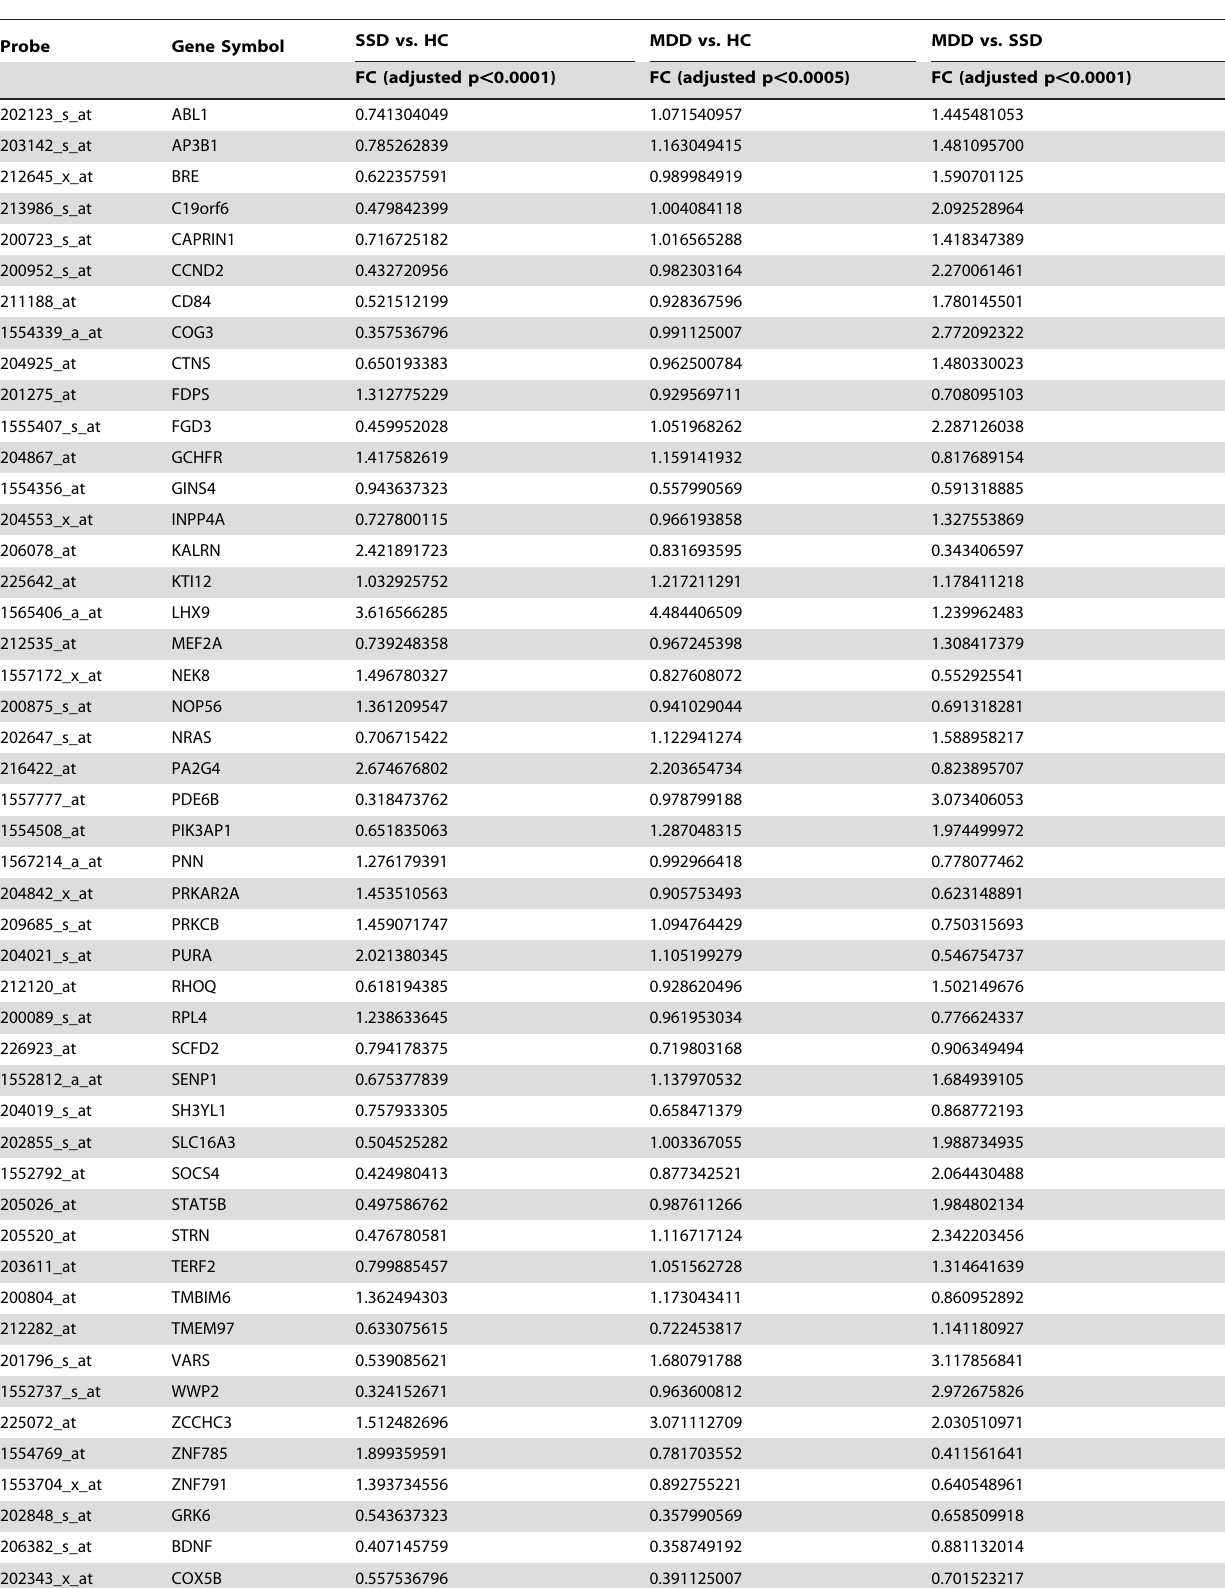
Table 1. Mostly potential signatures of gene expression profiles models for classification of MDD and